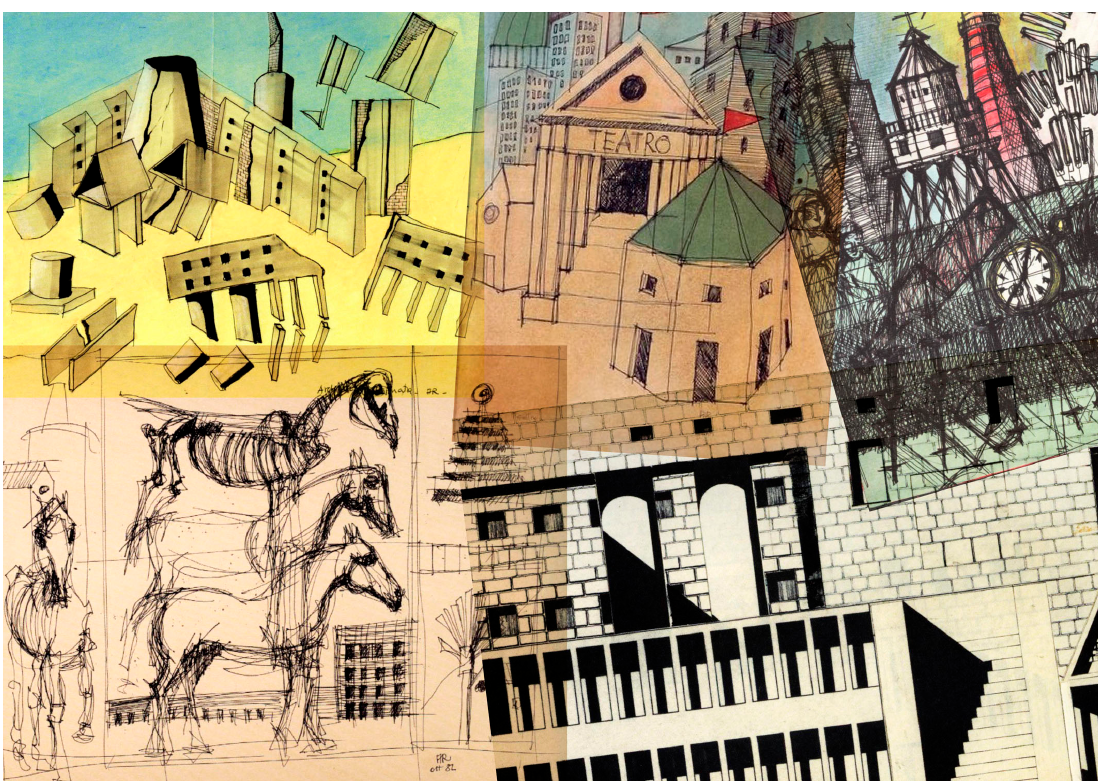
Figure 3. Aldo Rossi, sketches. Collage by Giulia Bertola.